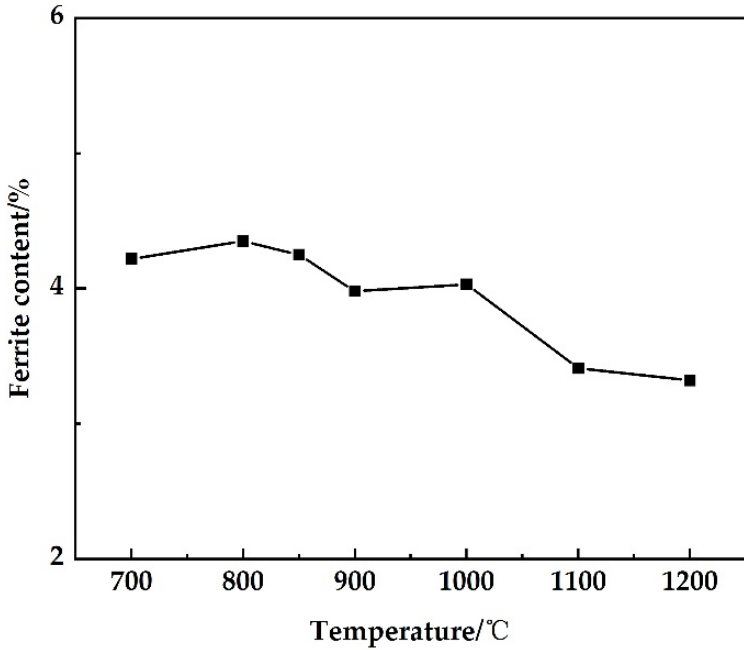
Figure 8. The relationship between ferrite content and temperature in 304 stainless steel.